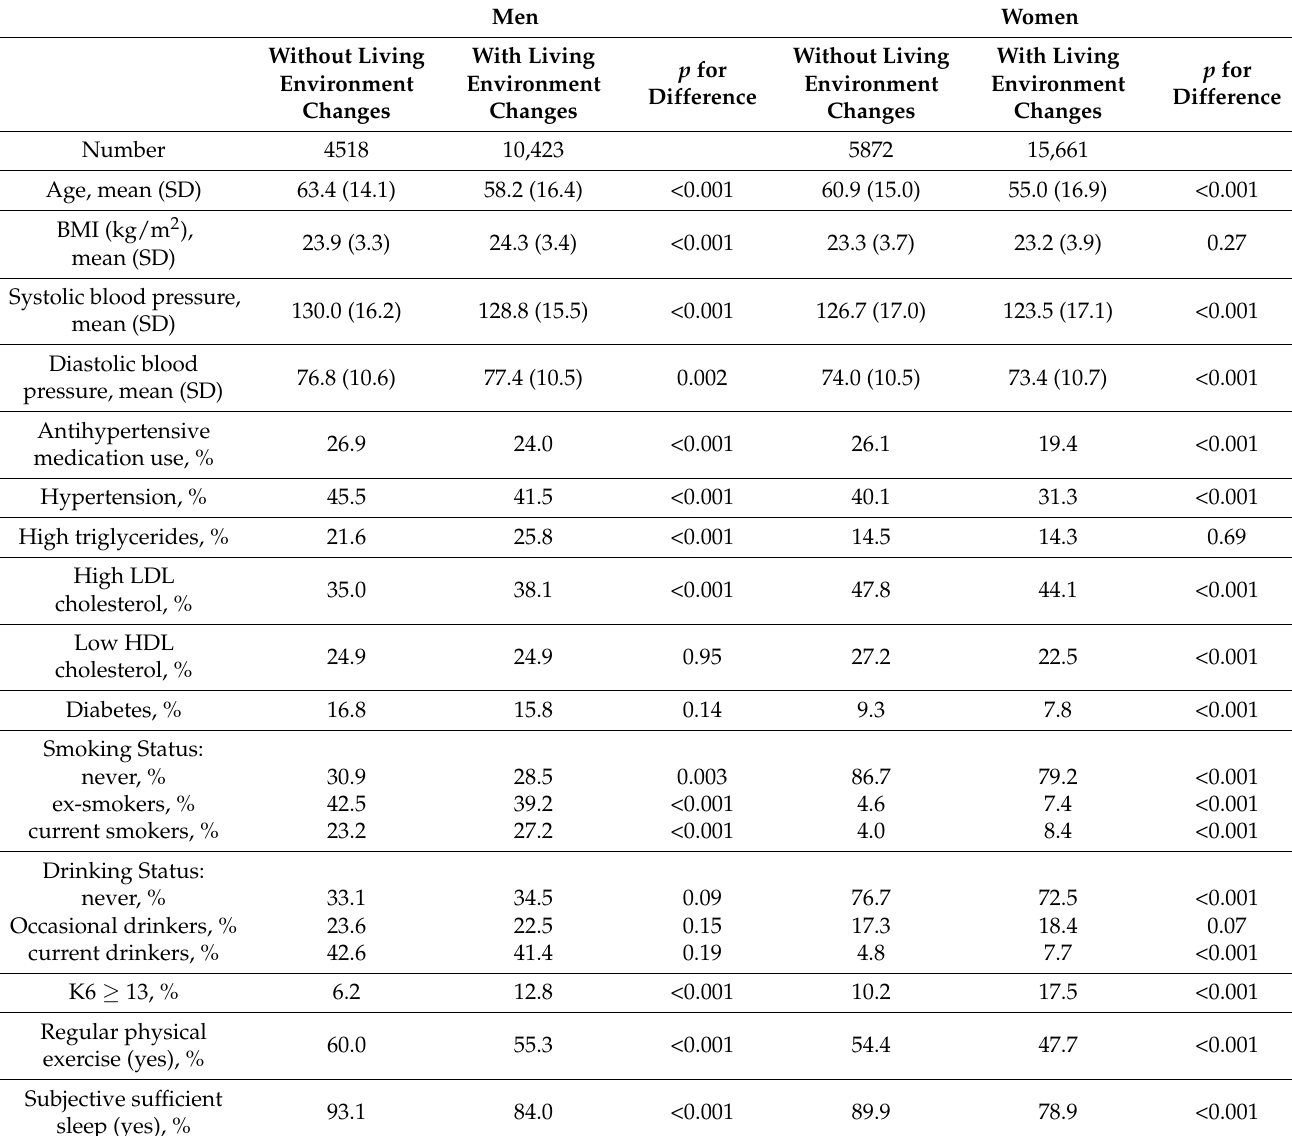
Table 1. Sex-specific baseline characteristics by changes in living environment (n = 36,474).